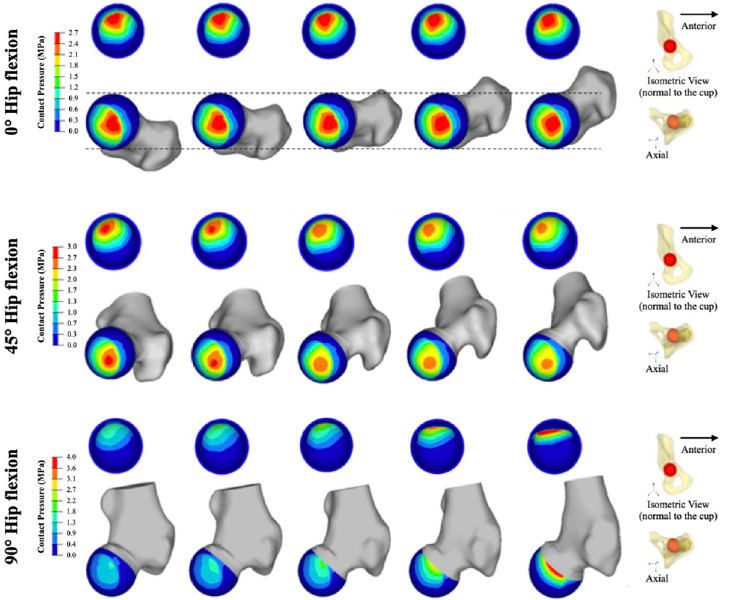
Fig 4. Illustration of the contact area across the acetabulum and head in different loading conditions. Contact area across the HRA when the joint is loaded in 0˚, 45˚, and 90˚ of hip flexion is influenced by femoral version (this example accounts for an acetabular cup in 40˚ of inclination and 15˚ of version).